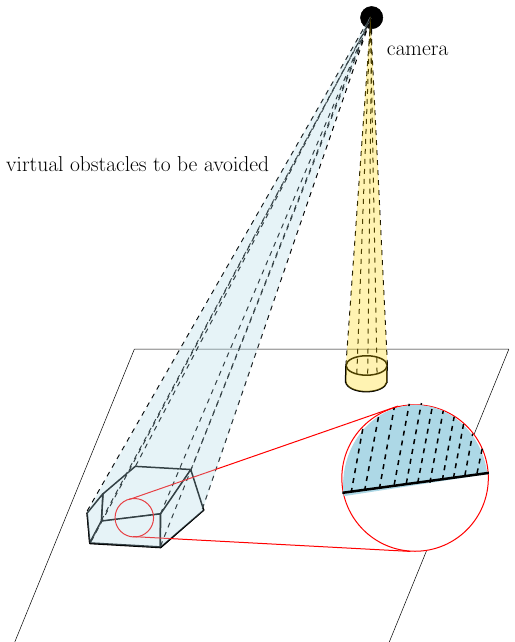
Figure 5. Pyramids representing the line of sight between the camera and two objects (only lines starting at the object’s vertices are shown on the left-hand side for